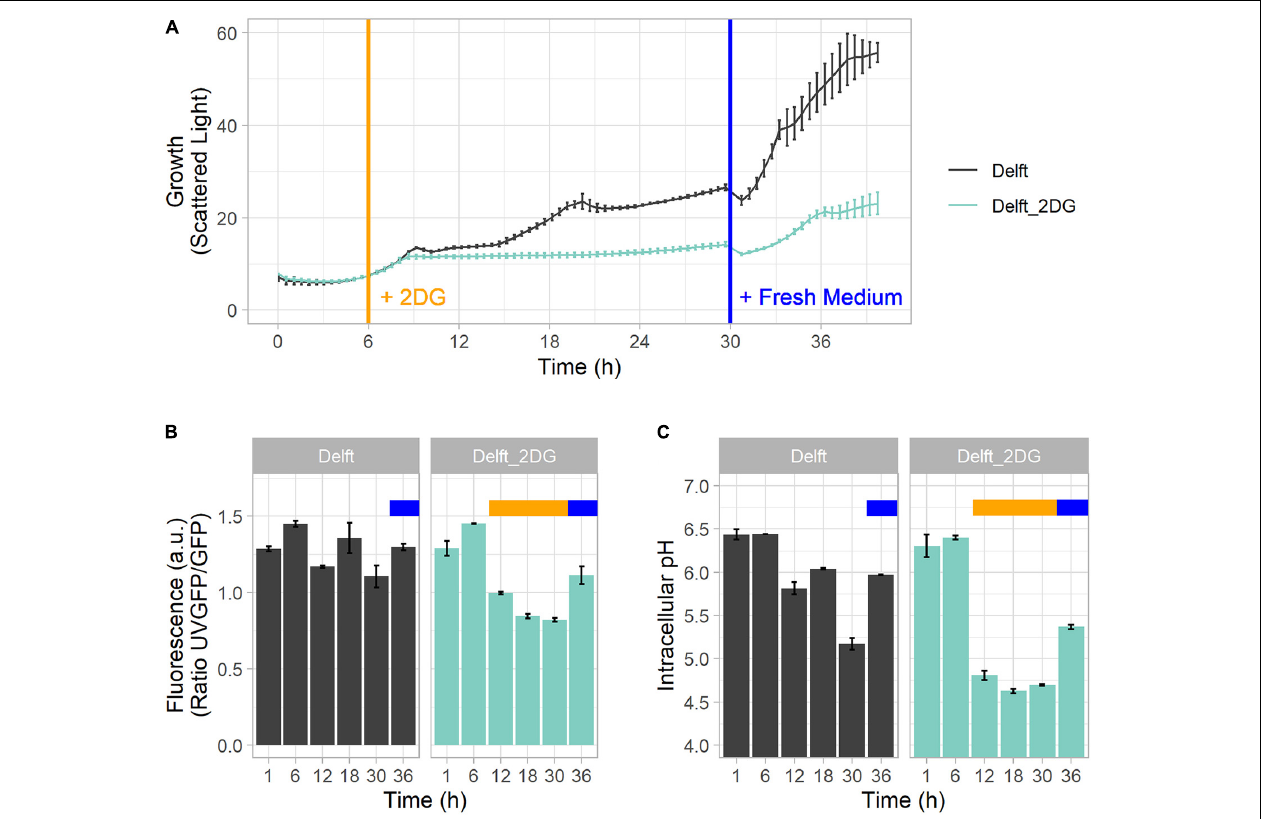
FIGURE 5 | Mutual connection between ATP and intracellular pH. (A) Growth curve profile of CEN.PK113-7D in Delft medium and Delft medium spiked at 6 h (orange line) with 2-deoxy-D-glucose (2DG) to stop growth and ATP production by glycolysis. In both conditions, medium was replaced at 30 h with fresh Delft medium (blue line). (B) ATP concentration detected with sfpHluorin. (C) Intracellular pH detected with QUEEN-2m. In Delft medium, the time points denote lag phase (1 h), first exponential phase (6 h), diauxic shift (12 h), second growth on ethanol (18 h), stationary phase (30 h), and growth after additional glucose supplementation (36 h). The orange bar denotes the presence of 2DG in the medium; the blue bar denotes replacement with fresh